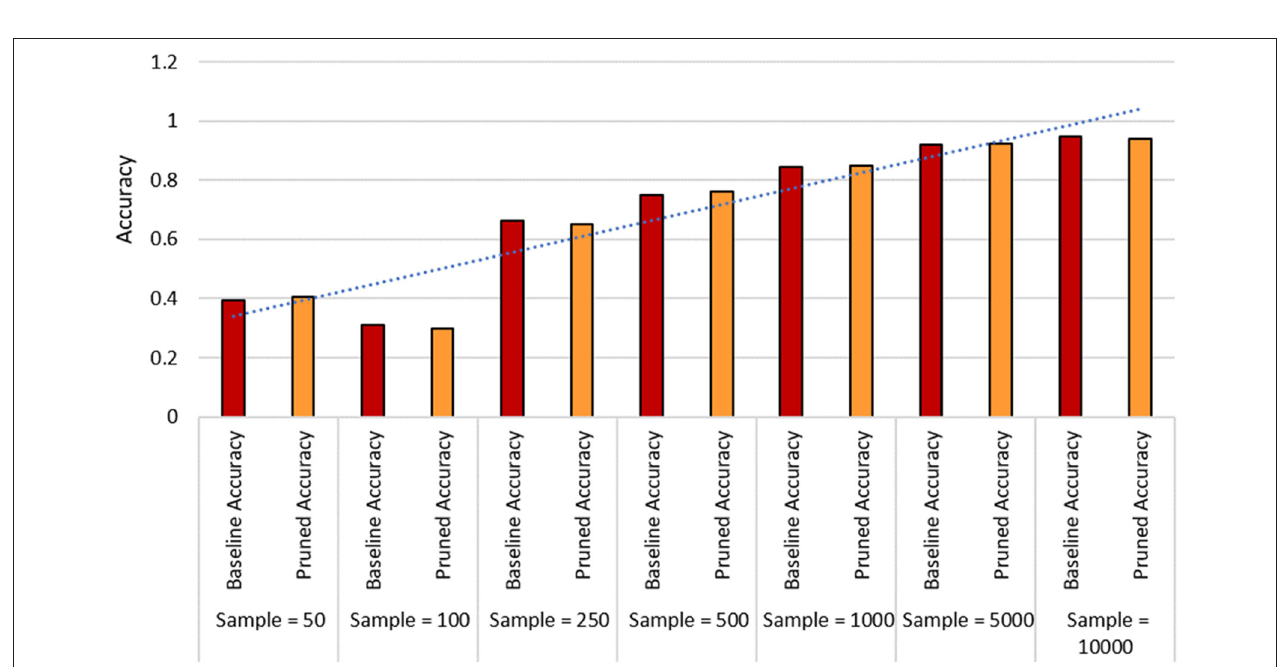
FIGURE 8 | Accuracy after performing initial sample-based pruning for different sample sizes.